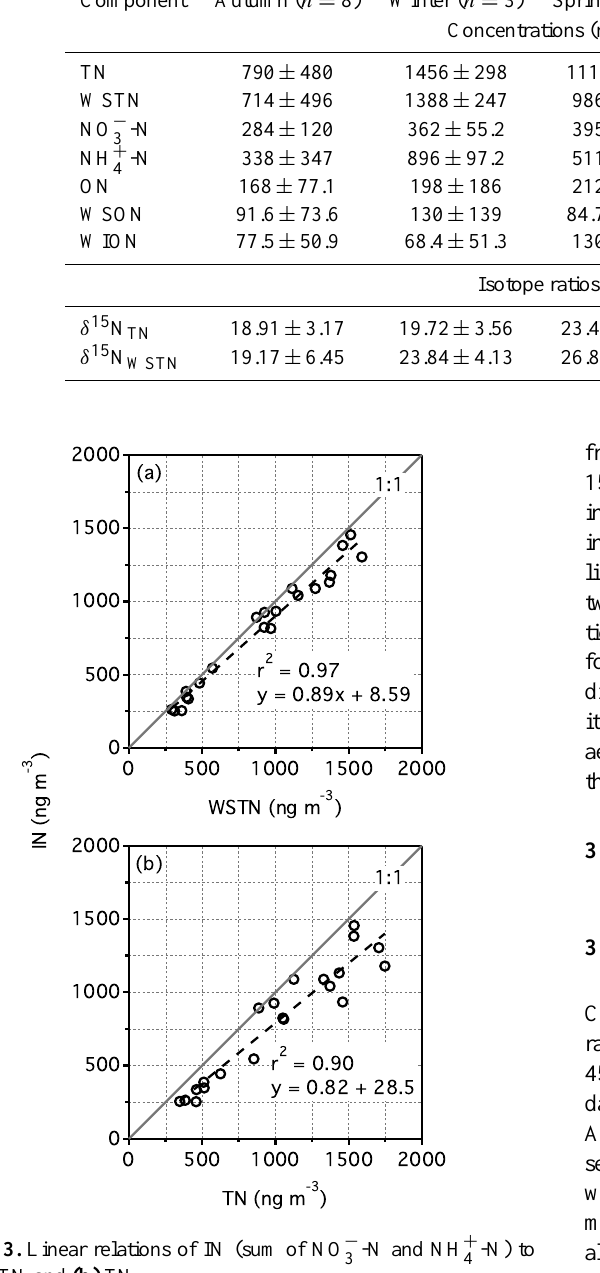
Figure 3. Linear relations of IN (sum of NO − (a) WSTN and (b)